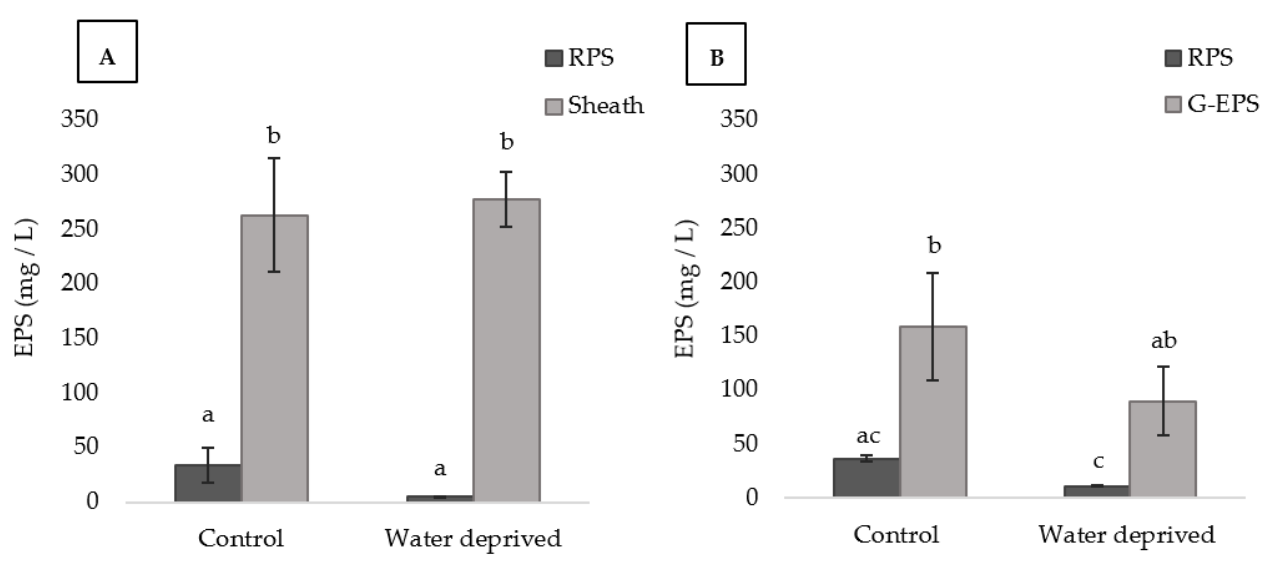
Figure 5. EPSs contents in P. ambiguum ( A ) and L. ohadii ( B ) biofilms (values represent the mean of N = 3, error bars represent SD). Different letters represent significant differences in each graph ( p < 0.05).